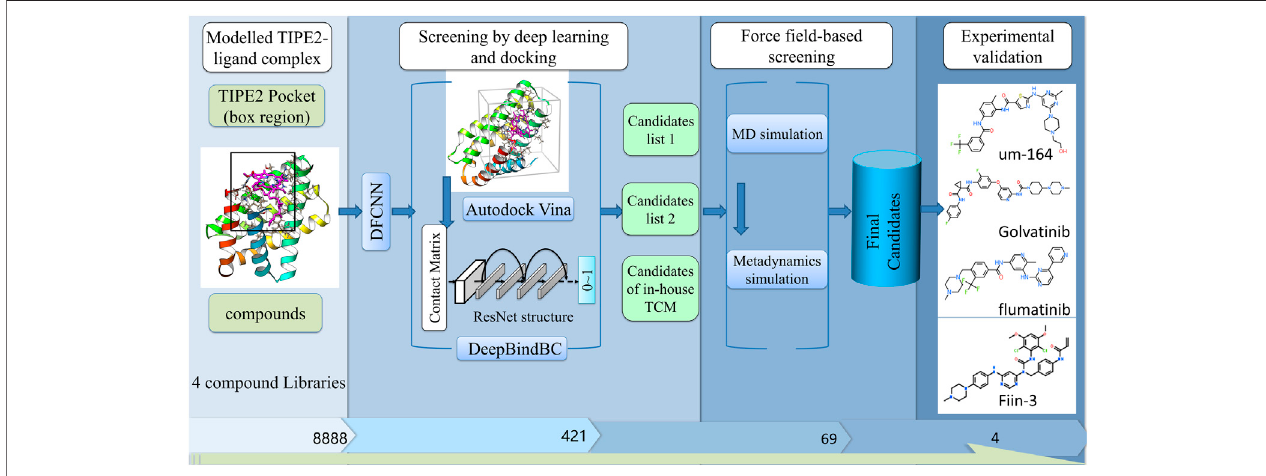
FIGURE 1 | The diagram of our screening pipeline. The screening procedures include preliminary screening by deep learning and docking, fi ne screening by force fi eld-based methods, and fi ne experimental validation.